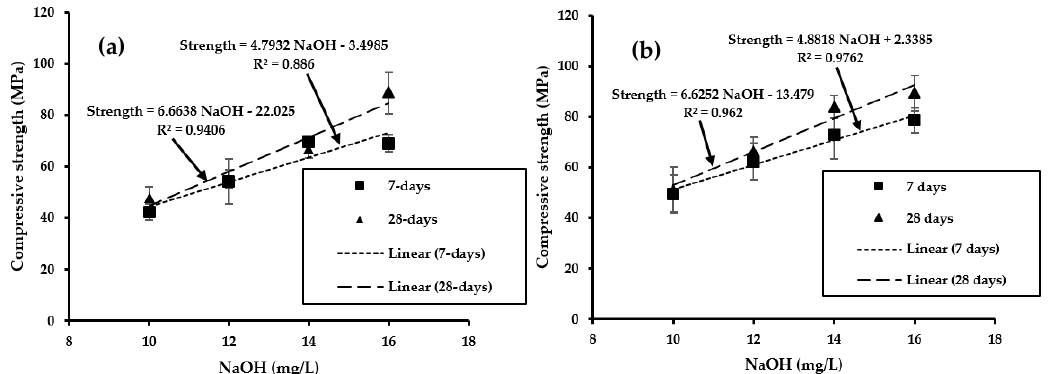
Figure 4. Regression model obtained using the compressive strength versus NaOH concentration of geopolymer cured at ( a ) 60 °C, and ( b ) 80 °C (fixed parameters of the ratio of water/fly ash of 0.025:1, Na 2 SiO 3 /NaOH of 2.5:1, NaOH/fly ash of 0.1:1, and aged of 7 days and 28 days) .